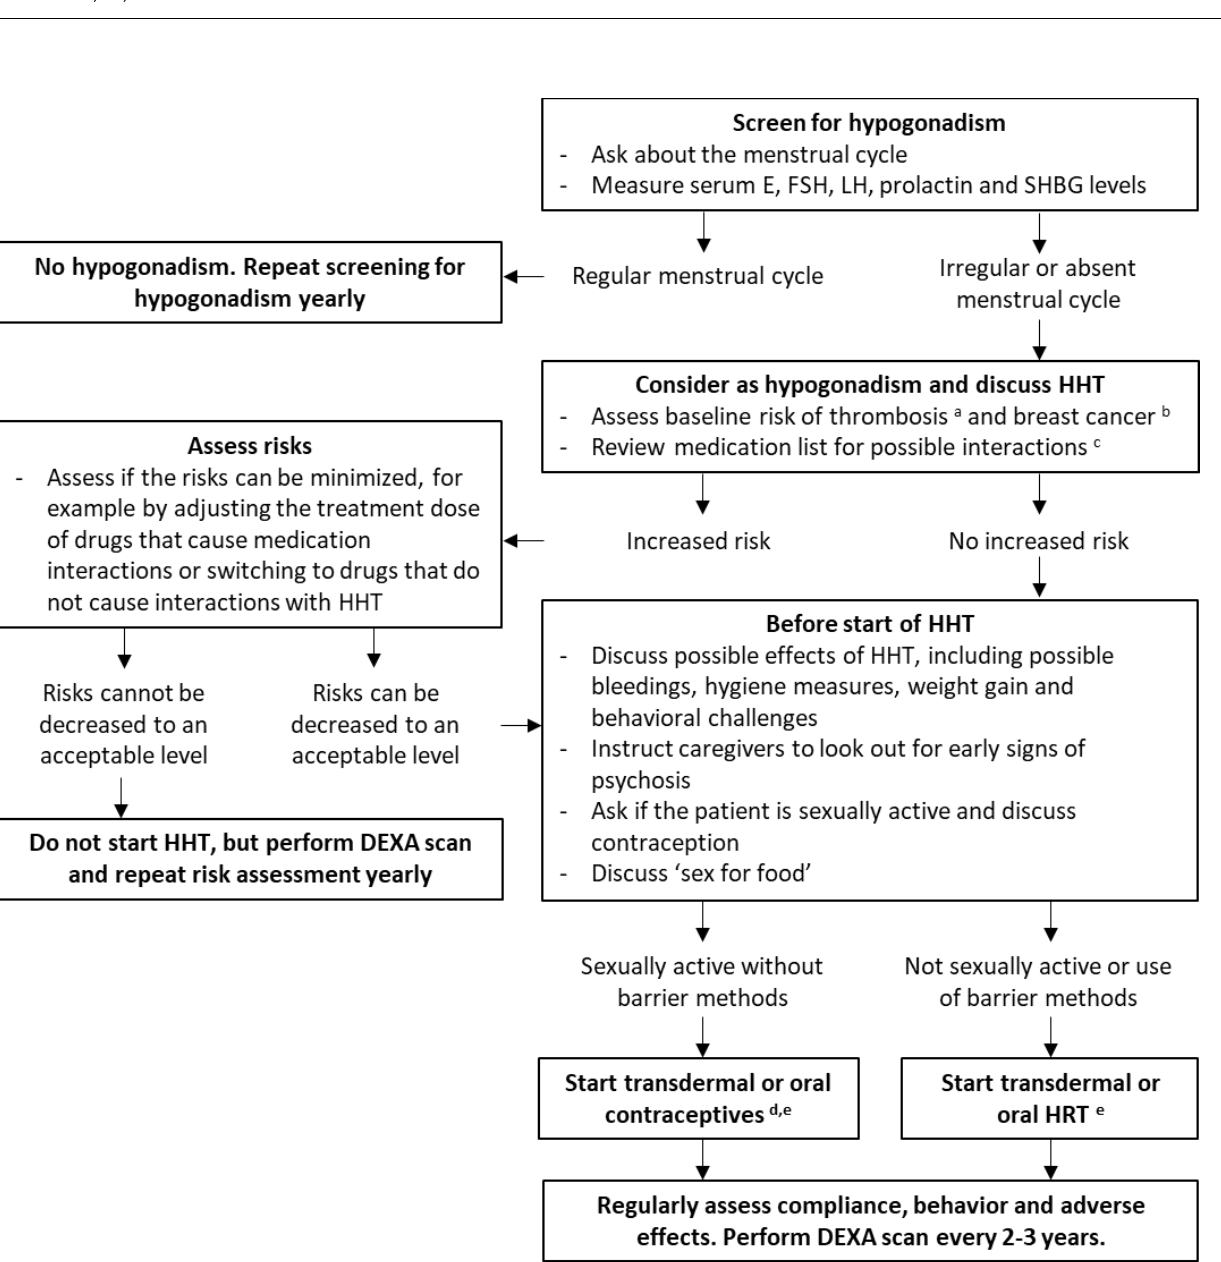
Figure 3. Recommendations for the treatment of hypogonadism in females with Prader-Willi syndrome, based on